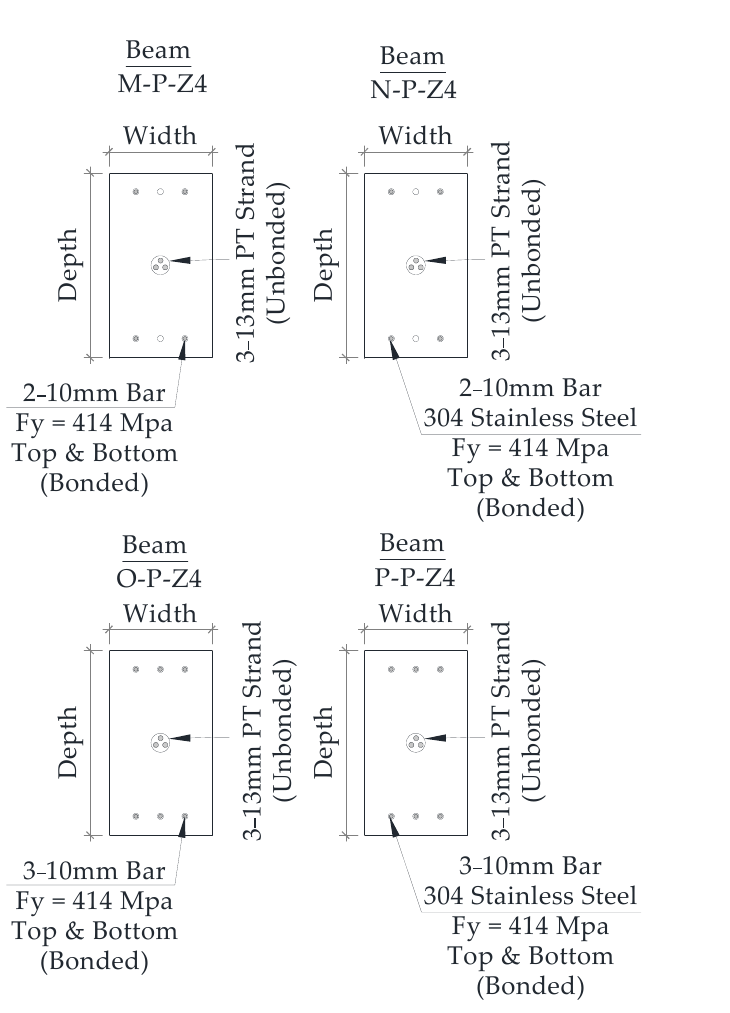
Figure 20. Four test specimens with various